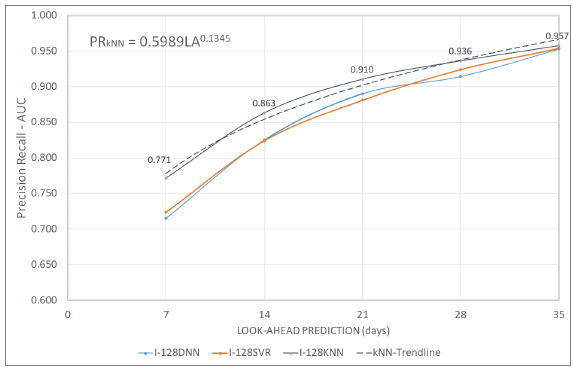
Figure 16. Kmeans*HDBSCAN Precision Recall